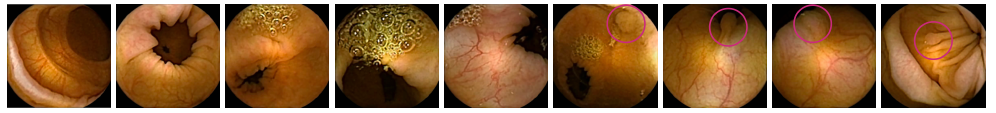
Figure 1. Five random images without polyp, and four images with a polyp obtained from the same patient. As can be seen, the images show high intra-class variability and small inter-class variance. Hence, they can be challenging for the system to classify.